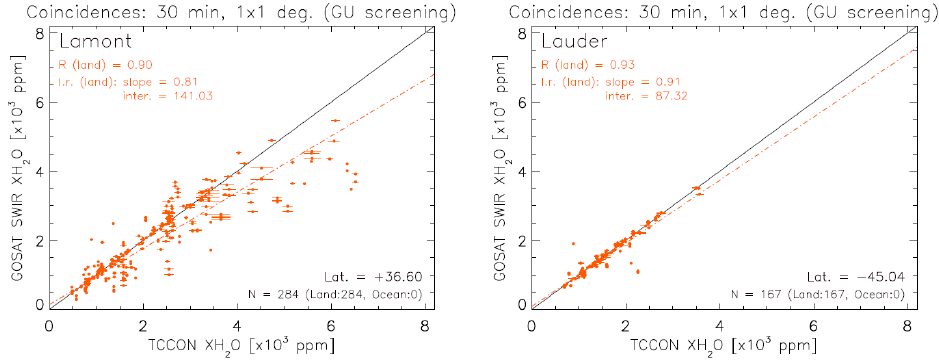
Figure 6. Scatter plot of the GOSAT TANSO-FTS XH 2 O and coincident TCCON soundings (criteria of ±30 min and ±1° in latitude/longitude) at the Lamont ( left ) and Lauder ( right ) TCCON sites. All coincidences were found for TANSO-FTS land scans.